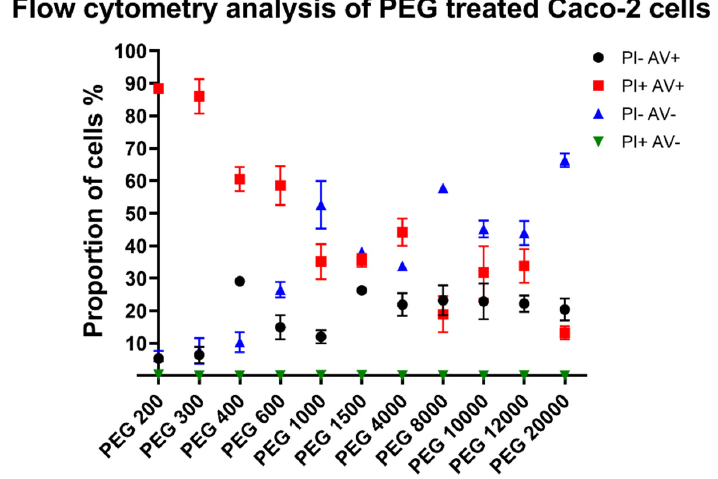
Figure 5. Proportion of living, dead, and apoptotic Caco-2 cells, measured by flow cytometry, treated with 1 mL of 30 w / v % solutions of PEGs, stained with propidium iodide (PI) and annexin V (AV). Each point represents the mean of triplicates. Data represented as percentage distribution of cells between necrotic (PI+ AV+), early apoptotic (PI − AV+), living (PI − AV − ), and incorrectly stained (PI+ AV − ) populations of three independent experiments. Distribution of the samples as mean ± SEM (PI − AV+; PI+ AV+; PI − AV − ; and PI+ AV − ): PEG 200: 5.3% ± 1.3%; 88.4% ± 0.6%; 6% ± 1.6%; and 0.3% ± 0.3%; PEG 300: 6.4% ± 2.5%; 86% ± 5.3%; 7.6% ± 4%; and ± 0% ± 0%; PEG 400: 29.1% ± 0.6%; 60.5% ± 3.7%; 10.3% ± 3.1%; and ± 0% ± 0%; PEG 600: 14.9% ± 3.7%; 58.5% ± 6%; 26.5% ± 2.4%; and 0.1% ± 0.1%; PEG 1000: 12% ± 2%; 35.1% ± 5.4%; 52.6% ± 7.3%; and 0.2% ± 0.1%; PEG 1500: 26.3% ± 0.7%; 35.5% ± 2%; 38.1% ± 1.2%; and 0.2% ± 0.1%; PEG 4000: 21.9% ±